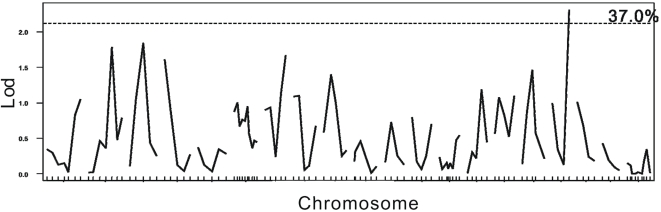
Linkage data for age at VO in the direct cross of F2 population (B6C3HF2).The horizontal axes indicate chromosomal locations and marker order between markers. No positive locus was investigated in this population.